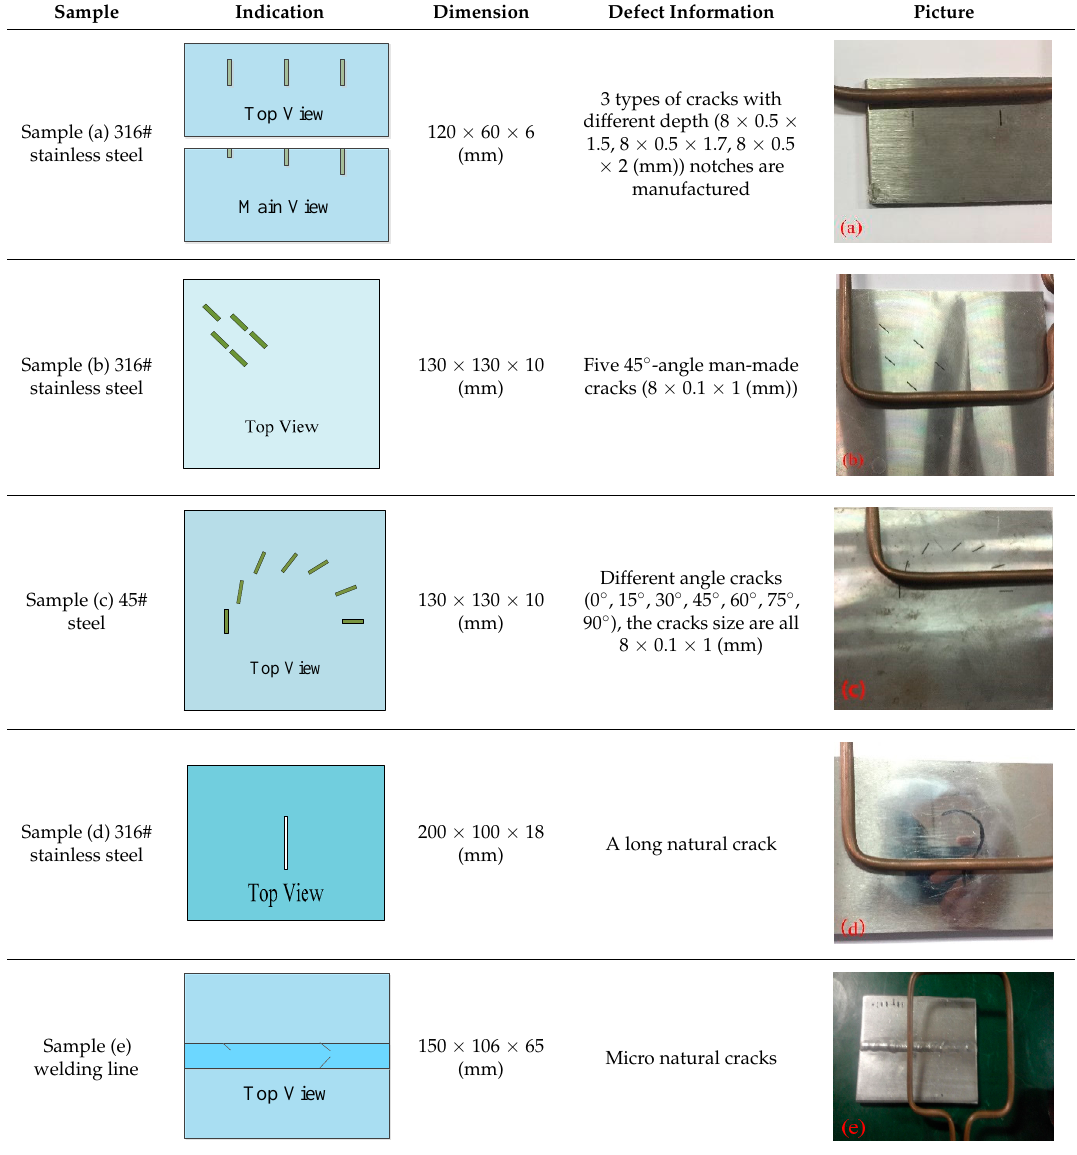
Table 2. The description of different samples.